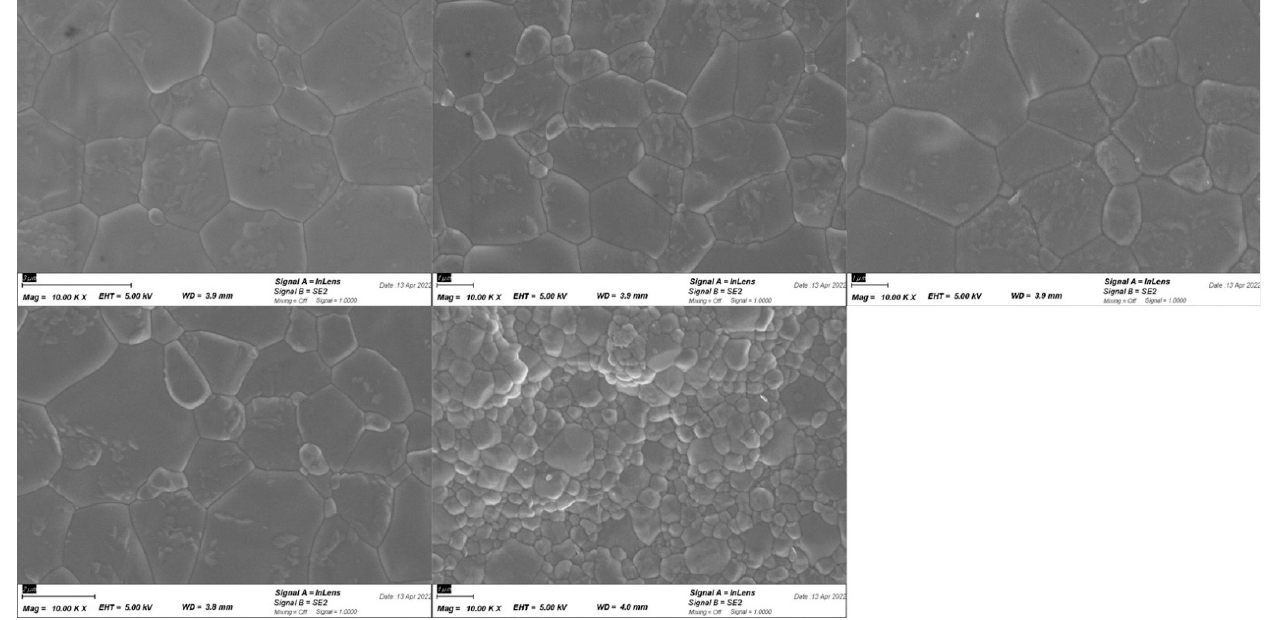
Figure 3. SEM Image of the different layers of 5Y-PSZ and 3Y-TZP.